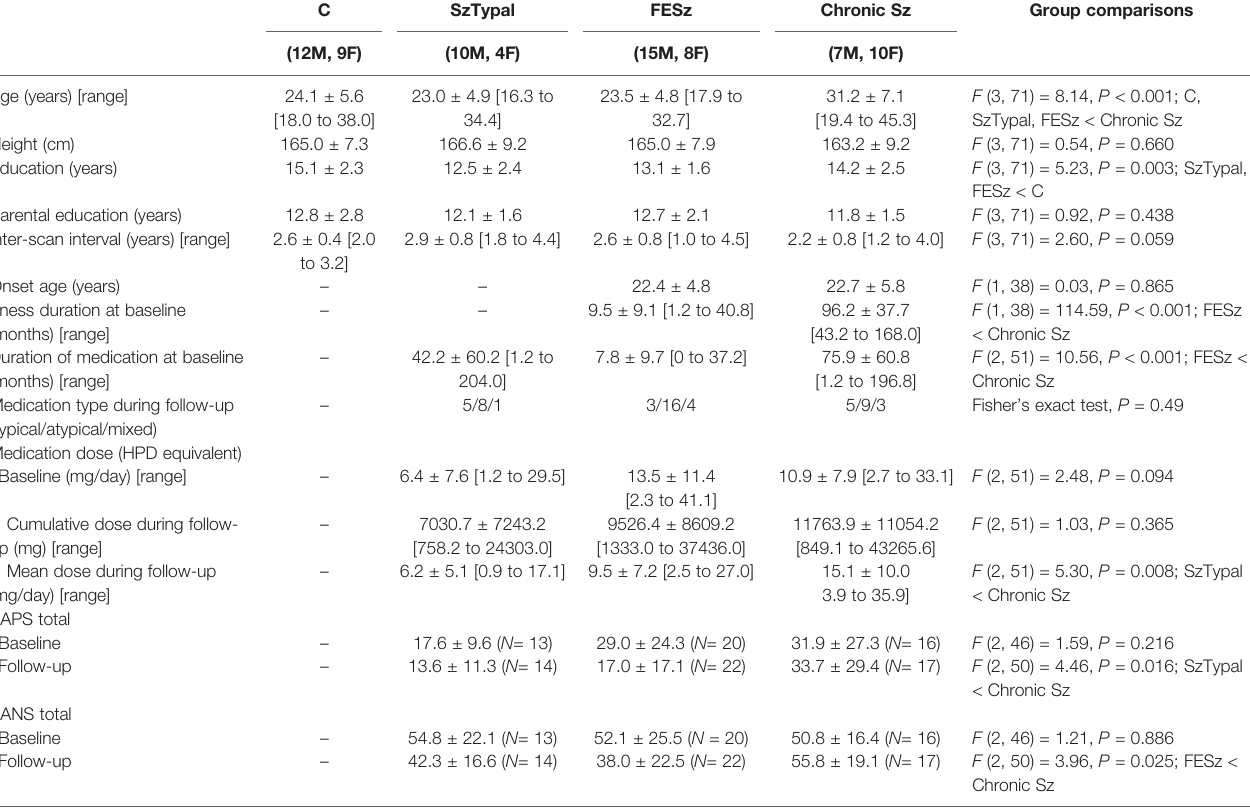
Values represent means ± SD unless otherwise stated. Groups were matched for gender (Chi-squared = 3.51, P = 0.319). C, controls; F, female; FE, First-episode; HPD, haloperidol; M,male; SANS, Scale for theAssessment of Negative Symptoms; SAPS,Scale forthe Assessment of PositiveSymptoms.